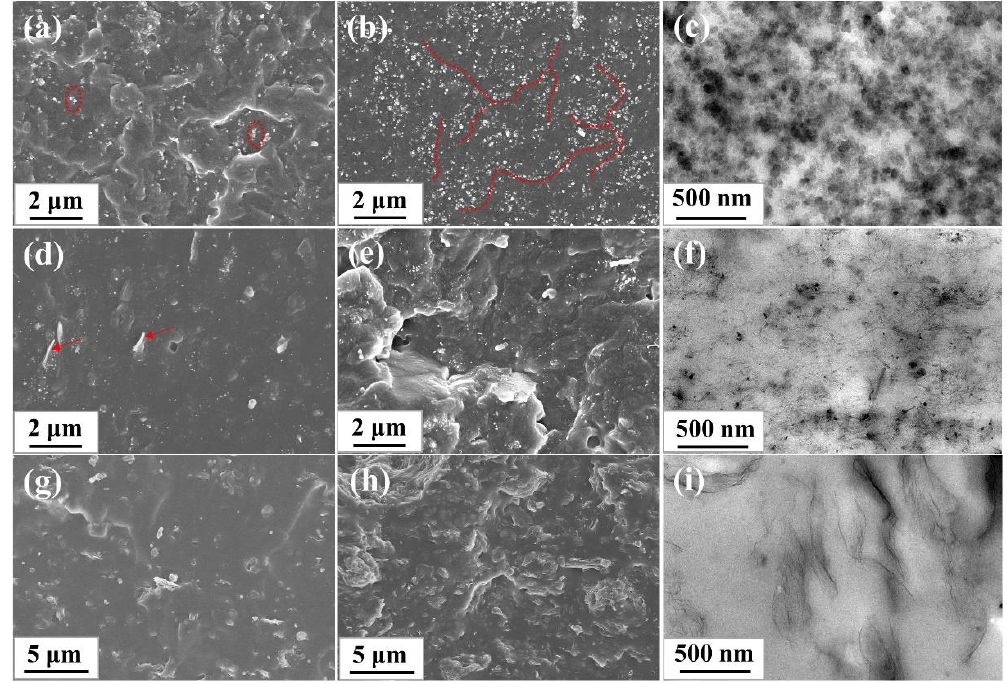
Figure 5. SEM images of different SBR composites: ( a ) CB/SBR-10; ( b ) CB/SBR-35; ( d ) CNTs/SBR-2; ( e ) CNTs/SBR-14; ( g ) GE/SBR-1; ( h ) GE/SBR-7. TEM images of ( c ) CB/SBR-35; ( f ) CNTs/SBR-8, and ( i ) GE/SBR-4 composites.